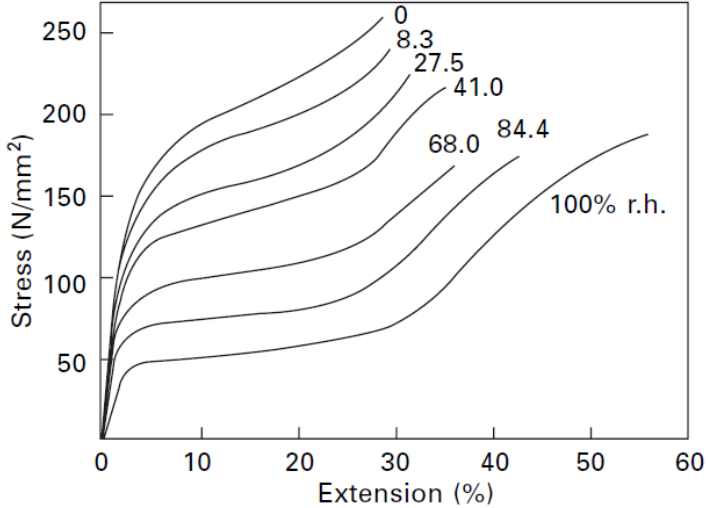
Figure3. E ff ectofrelativehumidityonstress–straincurvesofwoolatroomtemperature[41](RightsLink, Figure 3. Effect of relative humidity on stress–strain curves of wool at room temperature, [41] License numer 4875281426526, 2008, Physical properties of textile fibres, 4th